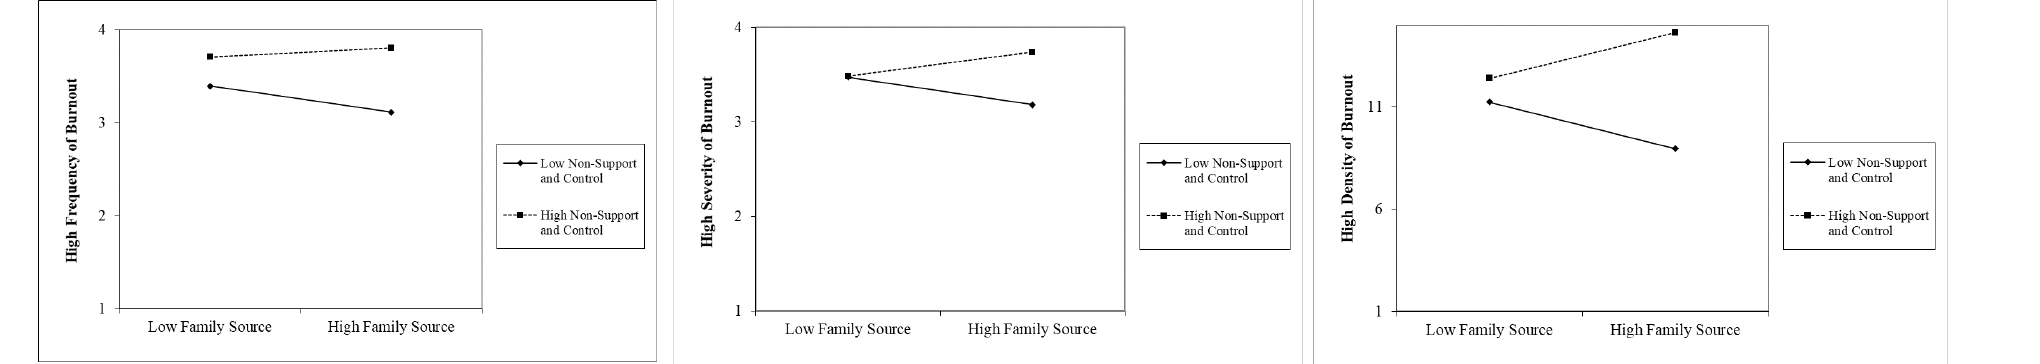
Figure 3. Significant Interactions for High Frequency, High Severity and High Density.